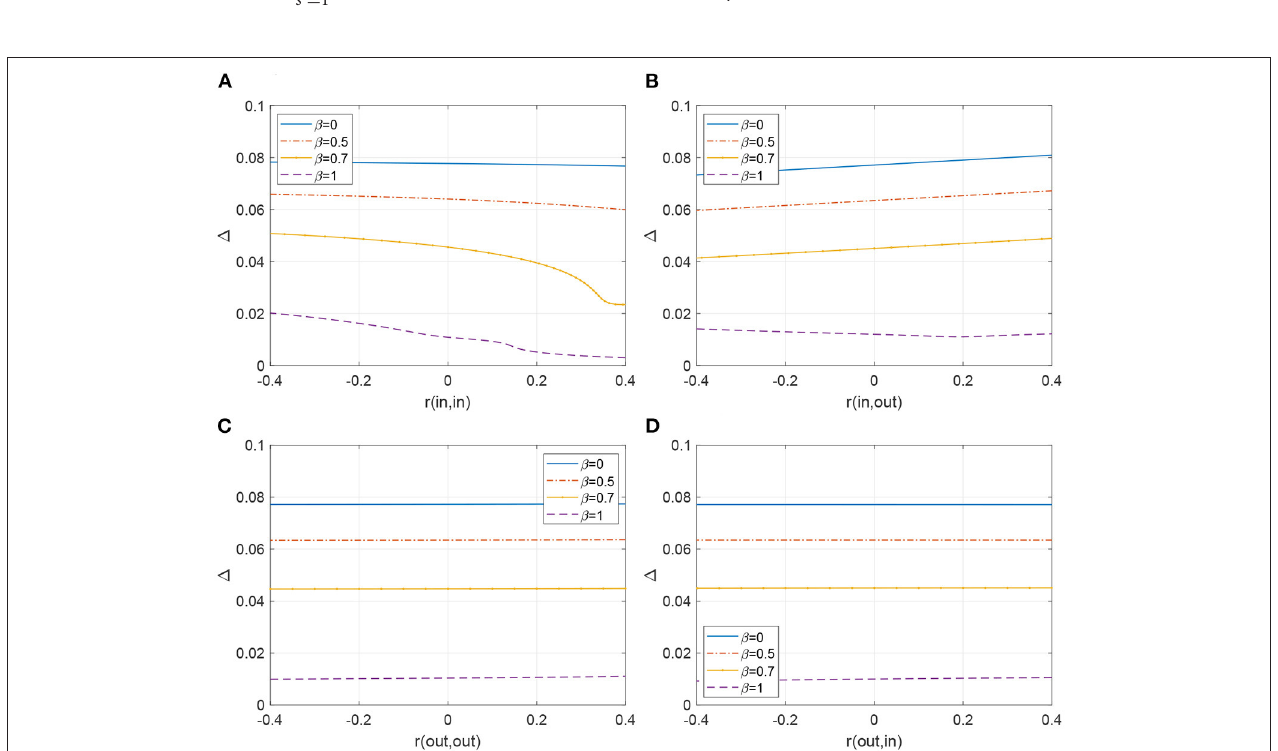
FIGURE 7 | (A–D) Hopf bifurcation curves as both 1 and one of the types of assortativity are varied. A stable periodic orbit exists below the curve. Other parameters: ǫ 0.2, ω 0 1, m 100, M = = = =